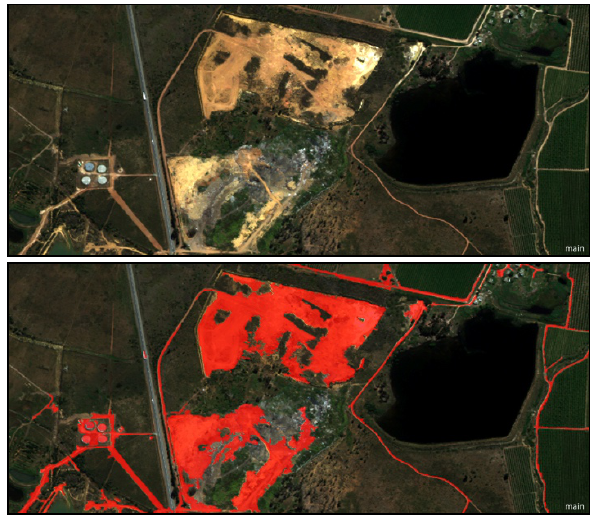
Figure 4. Bare ground identified using a threshold value of the yellow image band. WorldView-2 Image Copyright 2014, DigitalGlobe ©